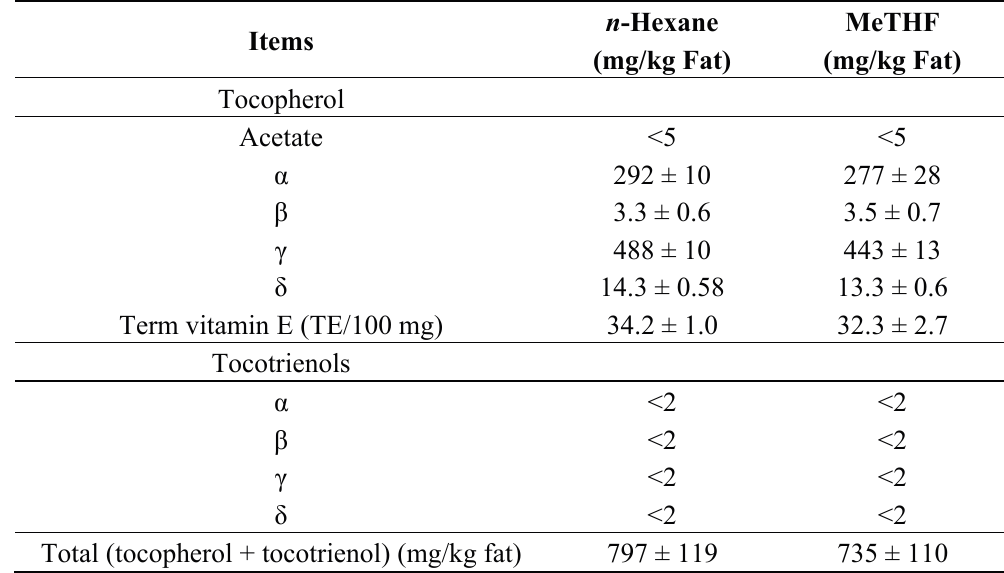
Table 6. Content of tocopherols and tocotrienols in extracted rapeseed oils with n -hexane and